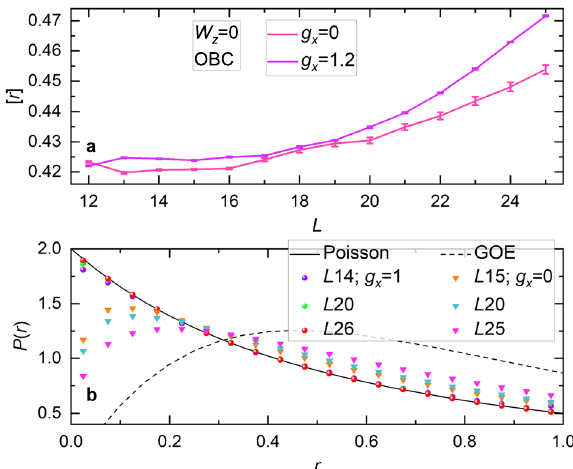
Fig. 3 Thermalization at a purely random point. a [ r ]-values of the chain for the two parameter sets ( g x = 0, W z = 0) and ( g x = 1.2, W z = 0). Both grow promptly toward the value of GOE with L , suggesting the system at both parametric points obeys ETH in the thermodynamic limit. b The probability distribution of the level-spacing ratio P ( r ) in cMBL (ensured by g x = 1, W z = 0), which closely traces the prediction of Poisson statistics [solid line, P Poi ( r ) = 2/(1 + r ) 2 ] under the increase of L , indicating the realization of a full MBL. By selecting g x = 0, W z = 0, the P ( r ) distribution switches to follow the Wigner surmise [dashed line, P GOE ð r Þ ¼ ð 27 = 4 Þð r þ r 2 Þ = ð 1 þ r þ r 2 Þ 5 = 2 ], signaling that therma- lization sets phase diagram for the quench-disordered Rydberg chain is identical to Fig. 1c, except that the black dot at g x = 1 moves